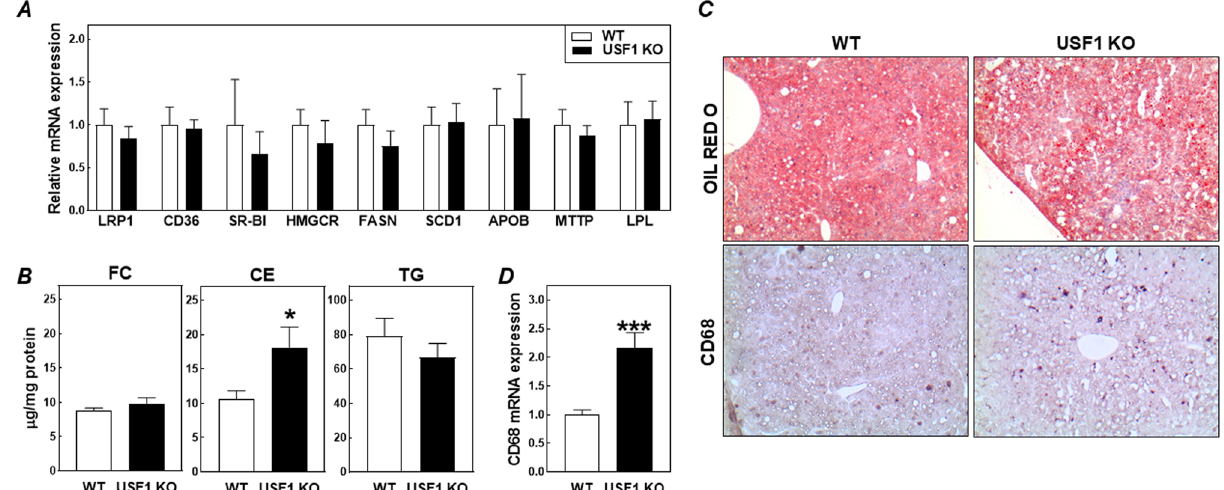
of 7 randomly chosen WT and USF1 KO bone marrow recipients, whilst the data in panel ( B ) represent the means ± SEM of 8 randomly chosen WT and USF1 KO bone marrow recipients. * P < 0.05, *** P < 0.001 versus